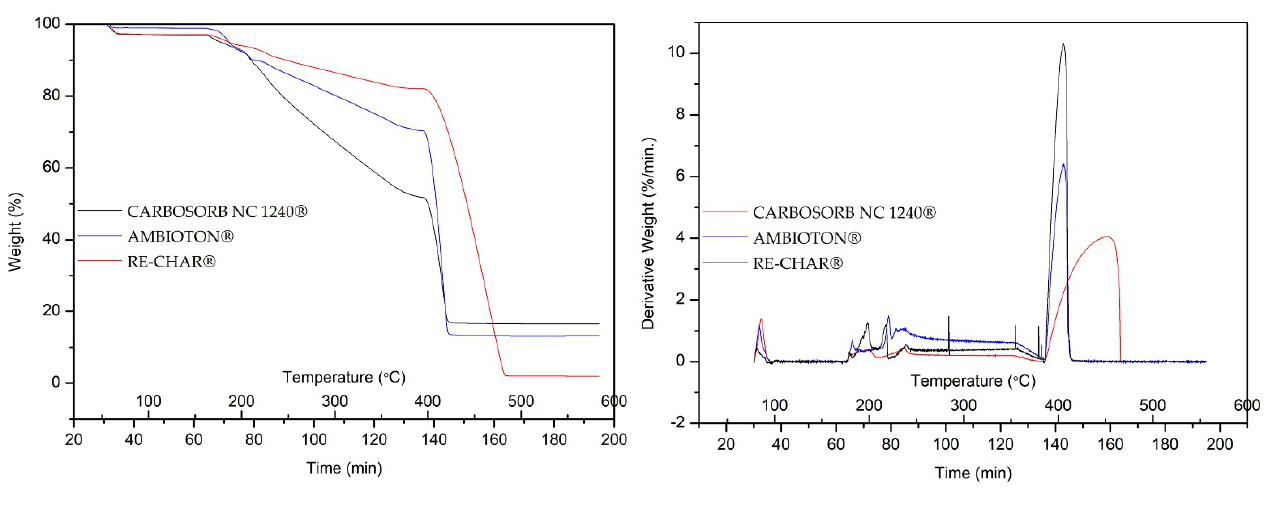
Figure 4. Weight (%) and derived weight (% min − 1 ) of volatile matter in CARBOSORB NC 1240 ® , AMBIOTON ® , and RE-CHAR ® .